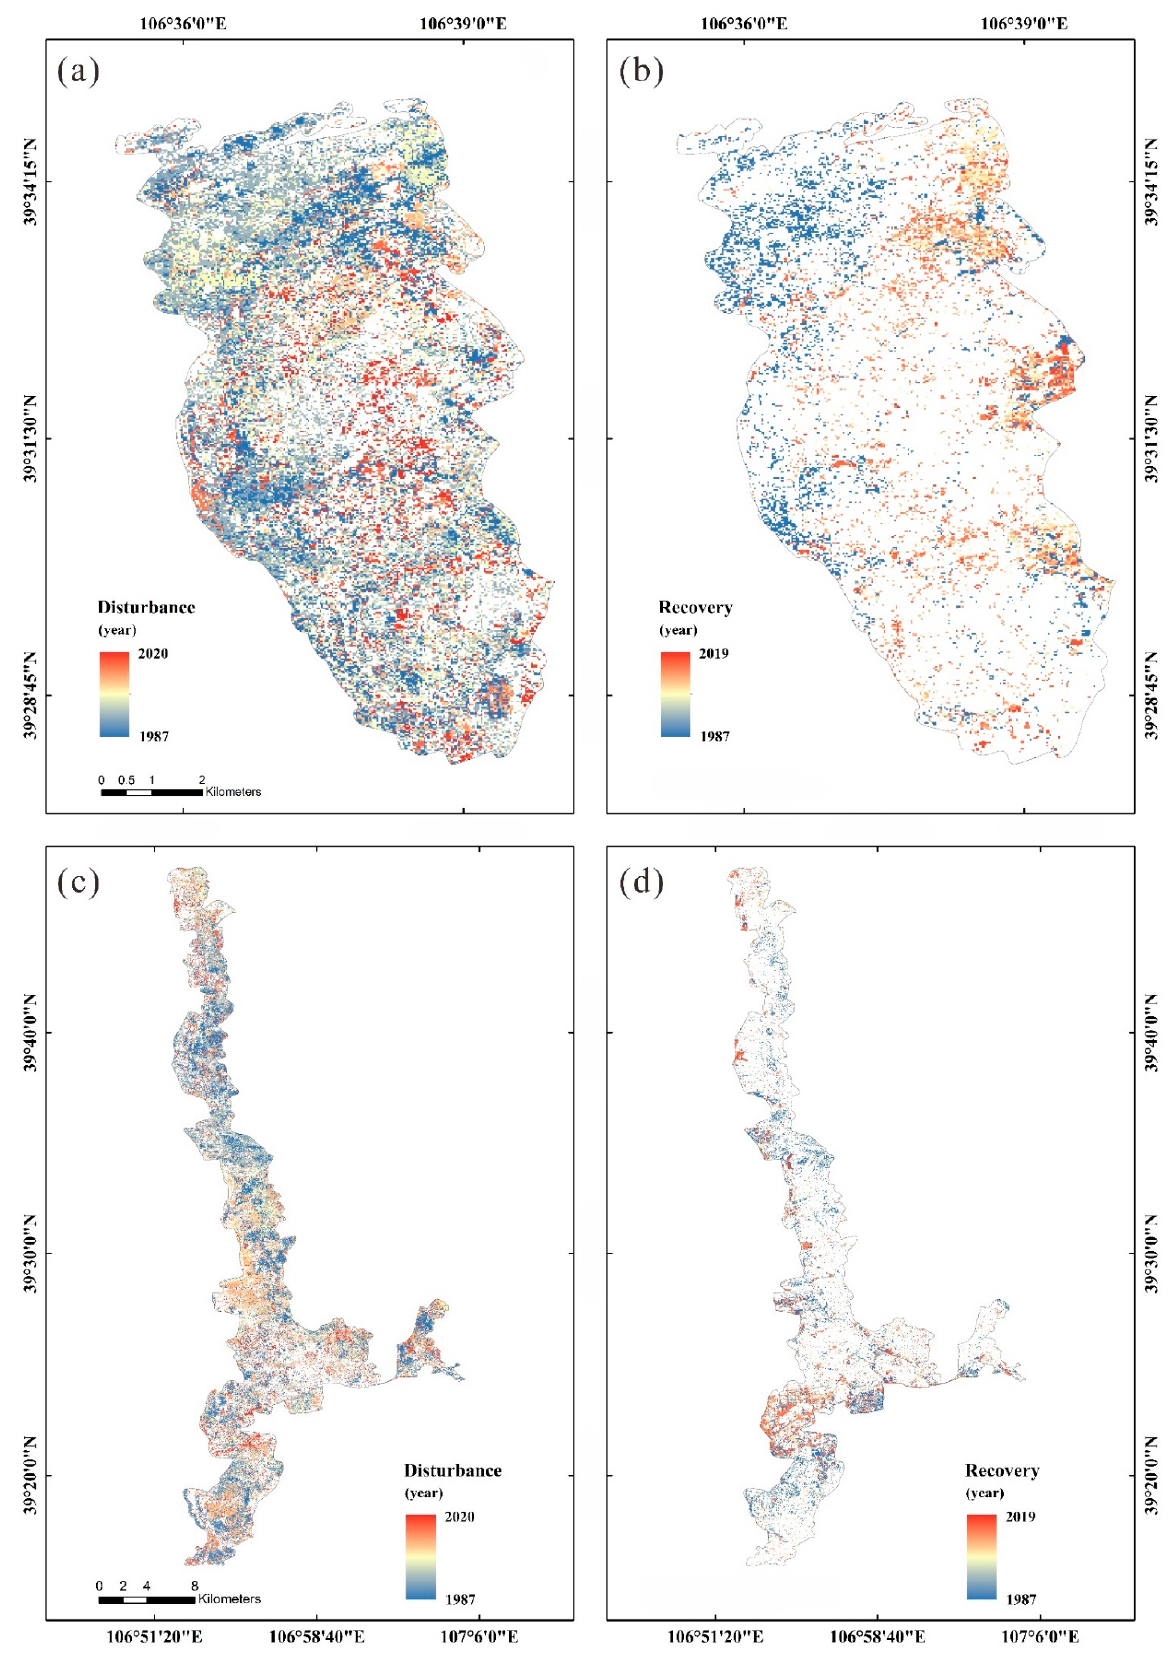
Figure 5. The year of disturbance and recovery occurrence. ( a ) disturbance in the western mine; ( b ) recovery in the western mine; ( c ) disturbance in the eastern mine; ( d ) recovery in the eastern